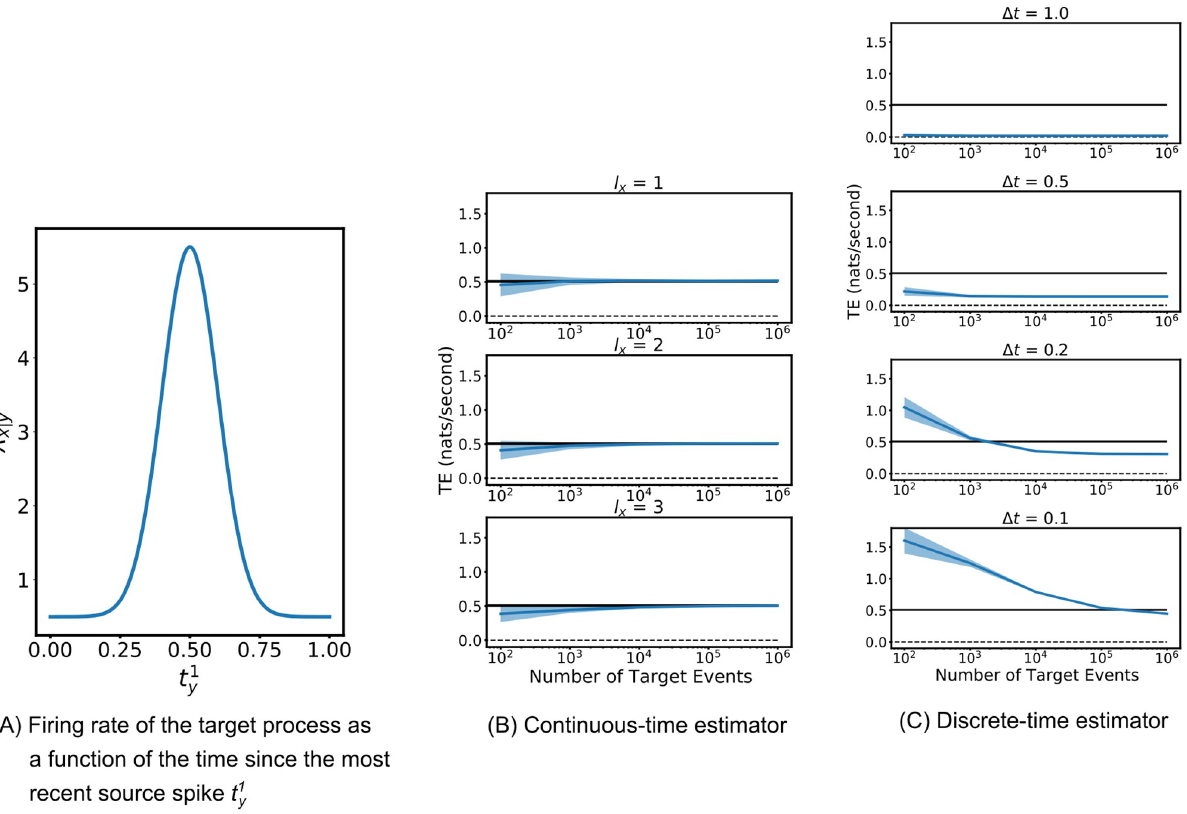
Fig 4. The discrete-time and continuous-time estimators were run on coupled point processes for which the ground-truth value of the TE is known. (A) shows the firing rate of the target process as a function of the history of the source. (B) and (C) show the estimates of the TE provided by the two estimators. The solid blue line shows the average TE rate across multiple runs and the shaded area spans from one standard deviation below the mean to one standard deviation above it. The black line shows the true value of the TE. For the continuous-time estimator the parameter values of N N X = 1 and k = 4 were used along with the ℓ 1 (Manhattan) norm. Plots are shown for three different values of the length of the target history component l X . For the discrete-time estimator, plots are shown for four different values of the bin width Δ t . The source and target history embedding lengths are chosen such that they extend back one time unit (the known length of the history